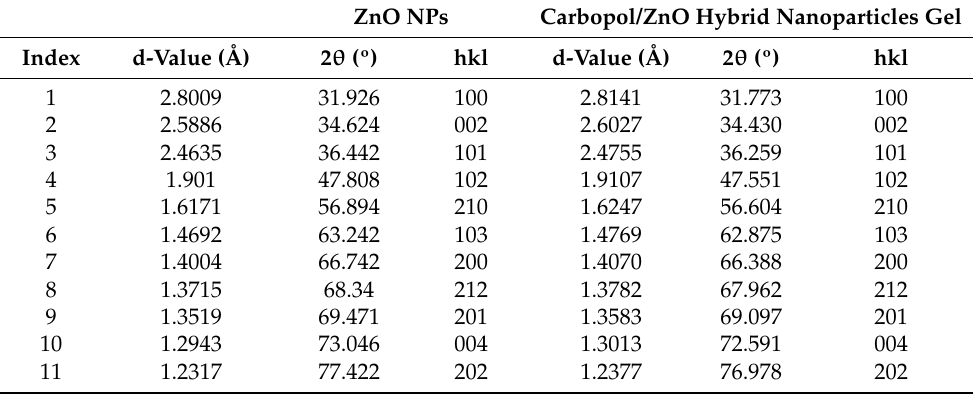
Figure 3. XRD patterns of the synthesized ZnO NPs and Carbopol/ZnO hybrid nanoparticles gel. Table 1. Appraised parameters of the XRD analysis of synthesized ZnO NPs and Carbopol/ZnO hybrid nanoparticles